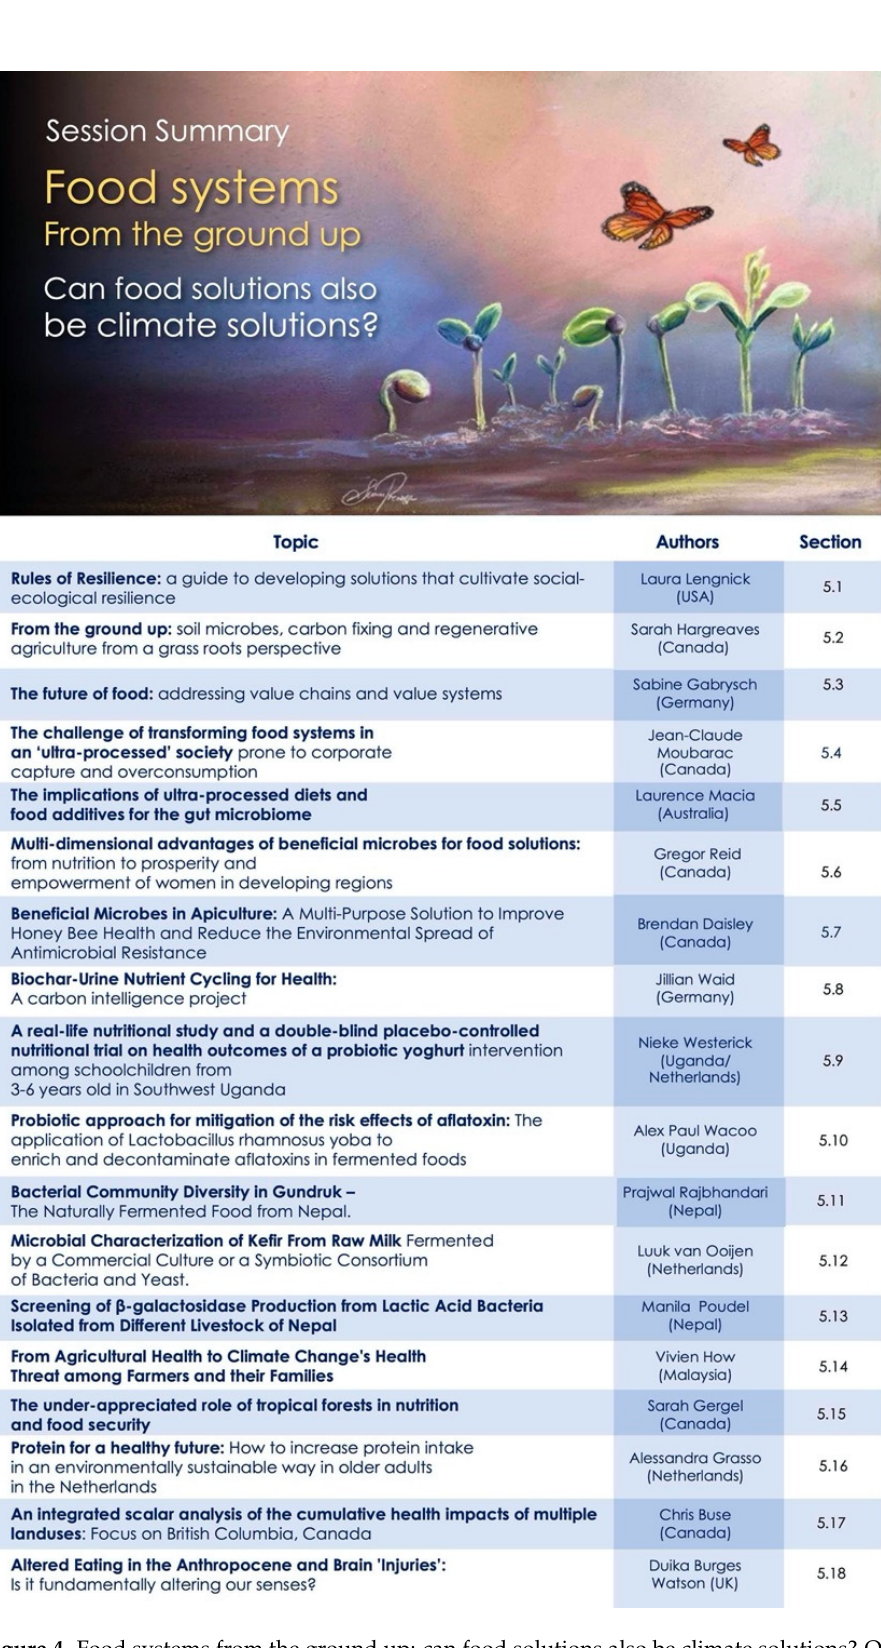
Figure 4. Food systems from the ground up: can food solutions also be climate solutions? Overview of topics and speakers in the session on food systems.